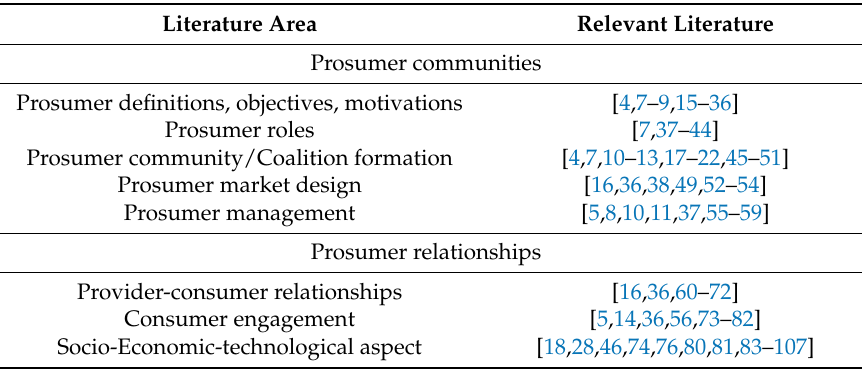
Figure 2. Prosumer Smart Grid Taxonomy. Table 1. Literature Classification based on